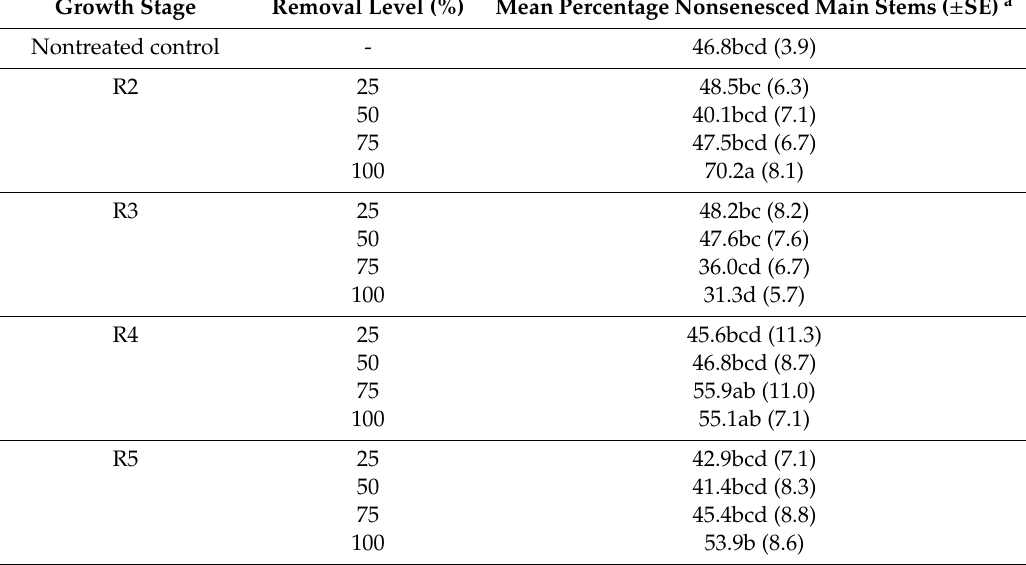
Table 2. E ff ect of the interaction of fruit removal plant stage and fruit removal level on percentage of nonsenesced main stem during 2016 and 2017.